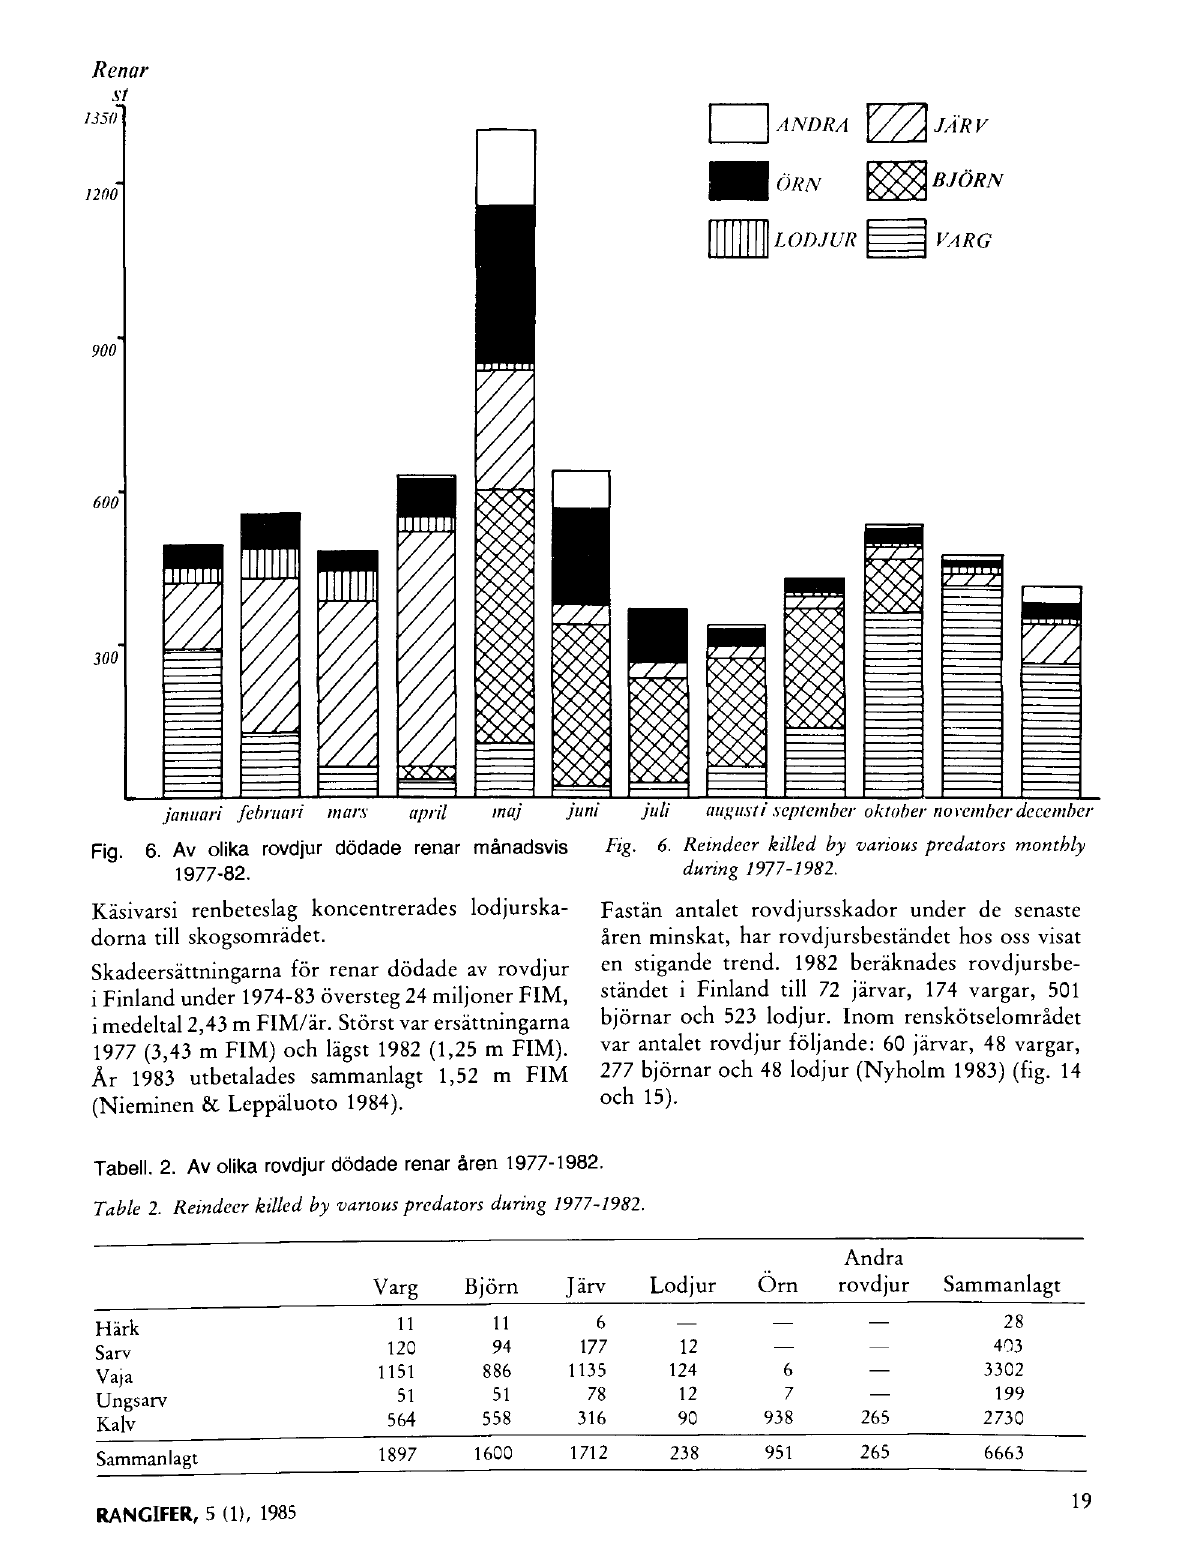
Table 2. Reindeer killed by various predators during